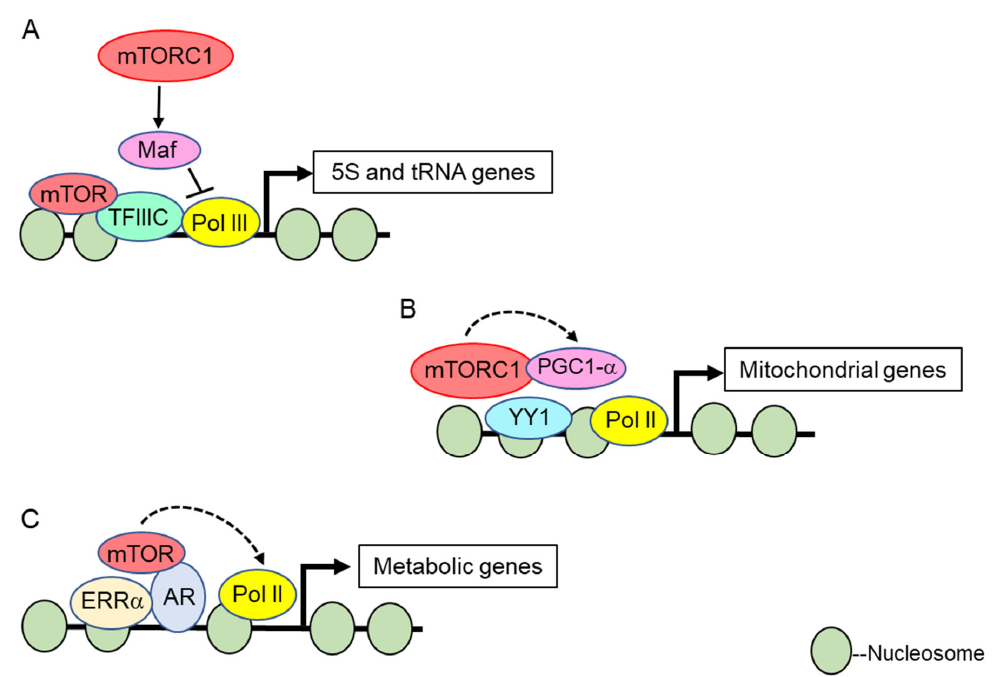
Figure 2. Role of the mTORC1 complex in transcriptional regulation. Known mTORC1 transcriptional roles at the 5S and tRNA genes ( A ), mitochondrial genes ( B ), and nuclear receptor activated metabolic genes ( C ). Dashed arrows indicate regulation that is either indirect, or not yet known to be direct. Solid lines indicate direct regulation. Details are outlined in the text. Only pathways whose mechanisms have been characterized in depth are